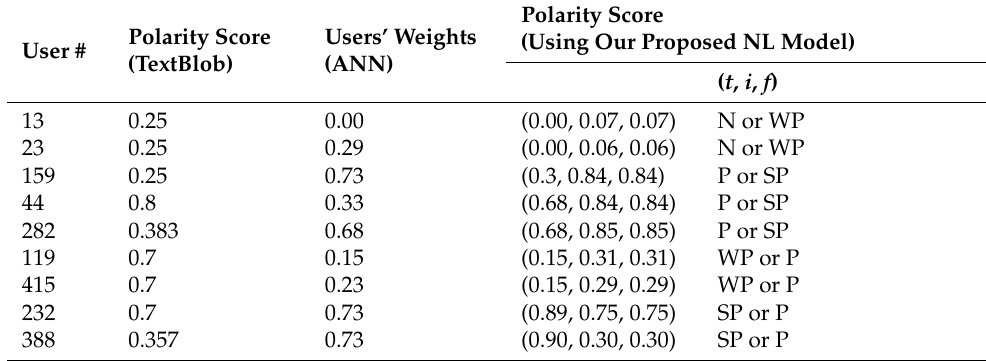
Table 6. Sample cases of undecided polarities in the dataset.